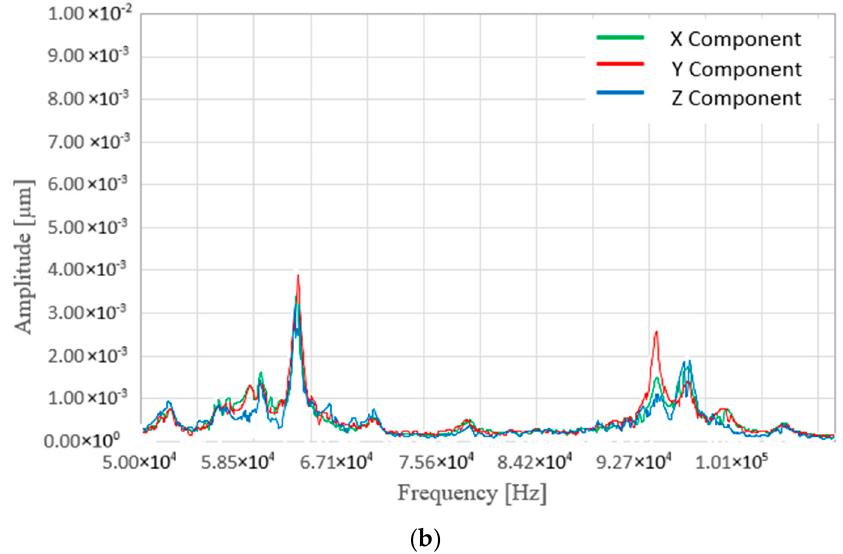
Figure 14. Measured vibrations of the actuator with disc-shaped flange: ( a ) deformations of the actuator with disc-shaped flange at 94.4 kHz; ( b ) amplitude vs. frequency graph, peaks of oscillations at 61 and 94.4 kHz. Red-X, green-Y, blue-Z coordinates.